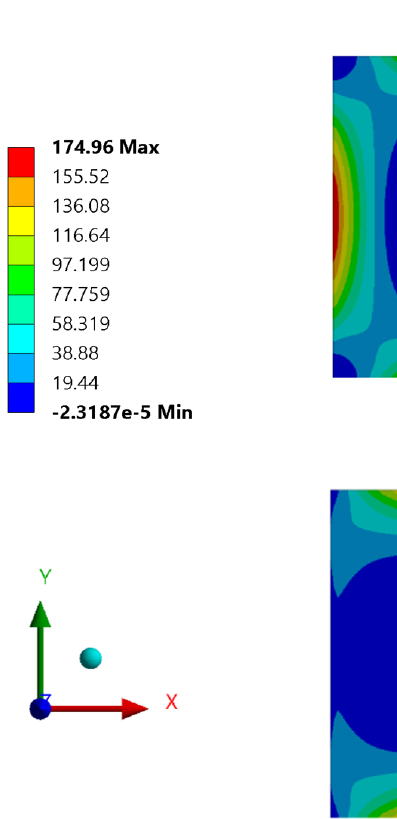
20 of 23 Figure 25. Variation in maximum displacement with different boundary conditions. The stress contour plot for plate specimens under the influence of varying boundary conditions is presented in Figure 26. In the case of plate specimens with fixed supports, the applied pressure was distributed and carried out by the supports and plate edges. The